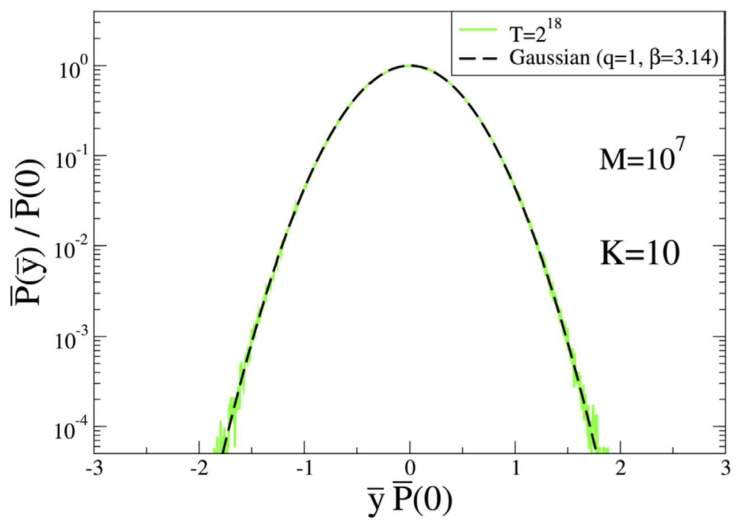
Figure 10. Normalized probability distribution function for K = 10 with T = 2 18 . From